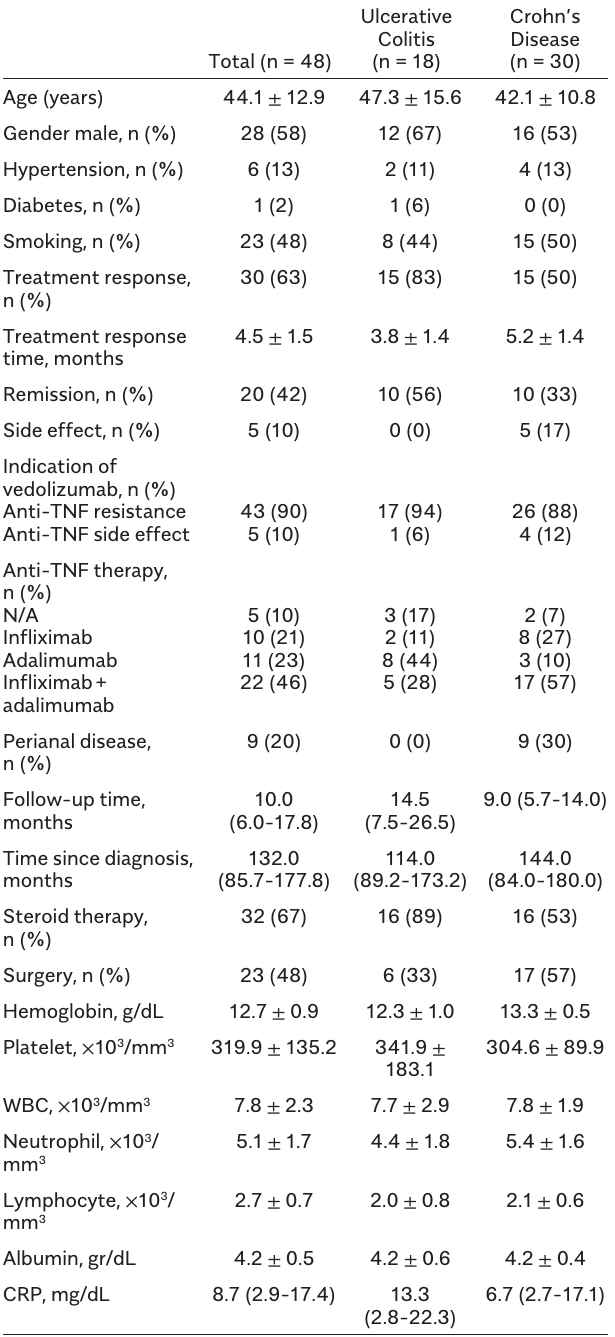
Table 1. Baseline Clinical and Laboratory